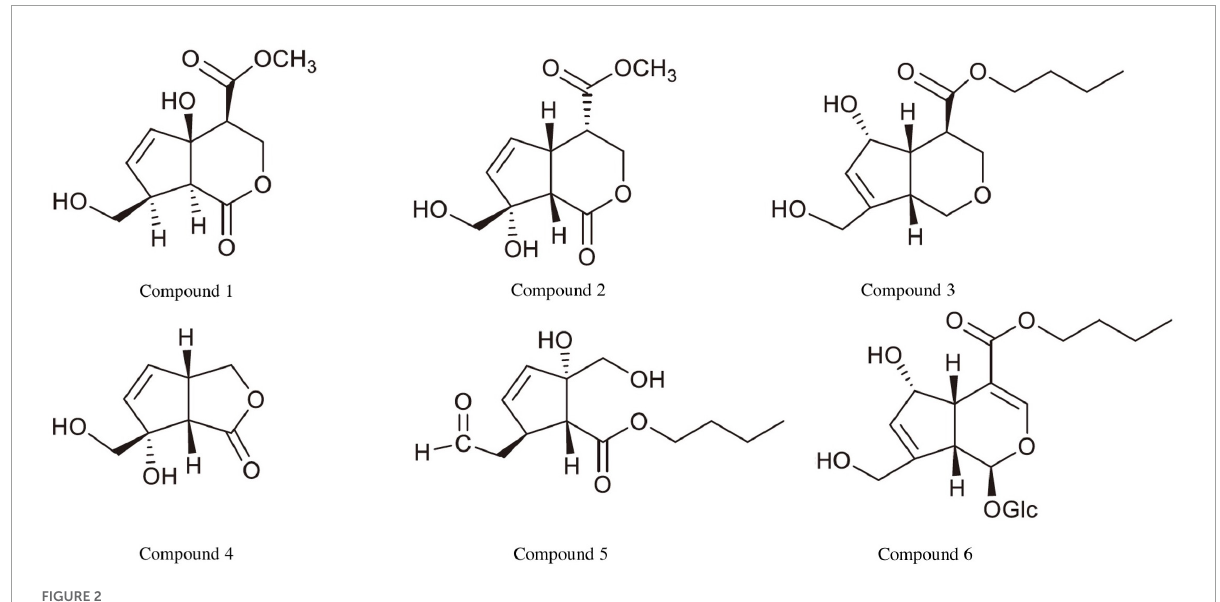
FIGURE2 The structures of the main iridoids in Morinda officinalis